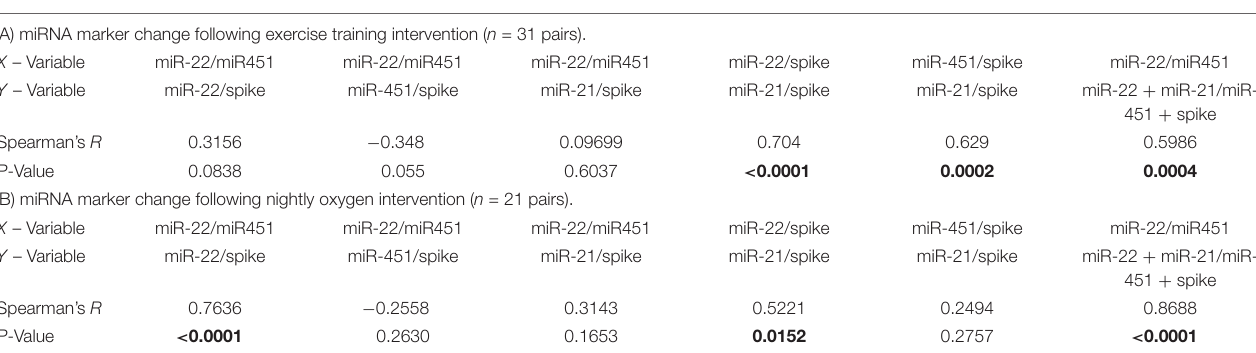
TABLE 3 | Correlations between different types of miRNA measurement readouts.